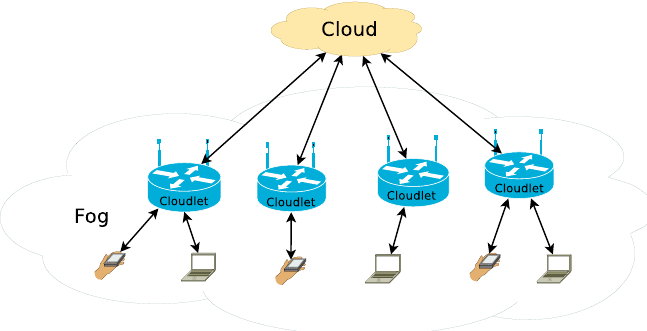
Figure 1. Multi-level edge/fog/cloud scenario